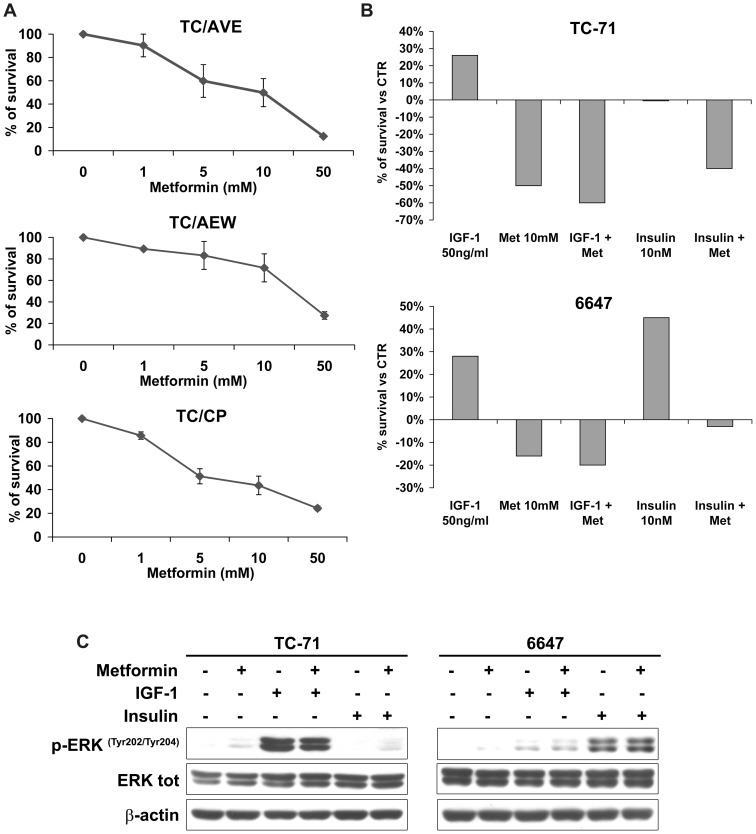
 Metformin effects are independent to IGF system activation.
A) Cell growth was assessed by MTT assay after 72h exposure to Metformin (mM) in cells resistant to anti-IGF-1R agents (TC/AVE, TC/AEW, TC/CP) where recently we demonstrated an increased expression of IR-A with a concomitant downregulation of IGF-1R and displayed as a percentage of survival over controls. Points, mean of two independent experiments; bars, SE; B) After overnight starvation, TC-71 and 6647 EWS cells were exposed to indicate concentration of metformin and/or IGF-1 and/or Insulin in IMDM containing 1% FBS for 48h. Cell growth was assessed by trypan blue assay and shown as percentage of growth over untreated controls. C) Starved cells were exposed to metformin (10 mM) for 4h in IMDM plus 1% FBS than stimulated with IGF-1 (50 ng/ml) or Insulin (10 nM) for 15min. After harvesting, cells were lysed and prepared for immunoblot analyses for p-ERK and total ERK. β-Actin was used as loading control.